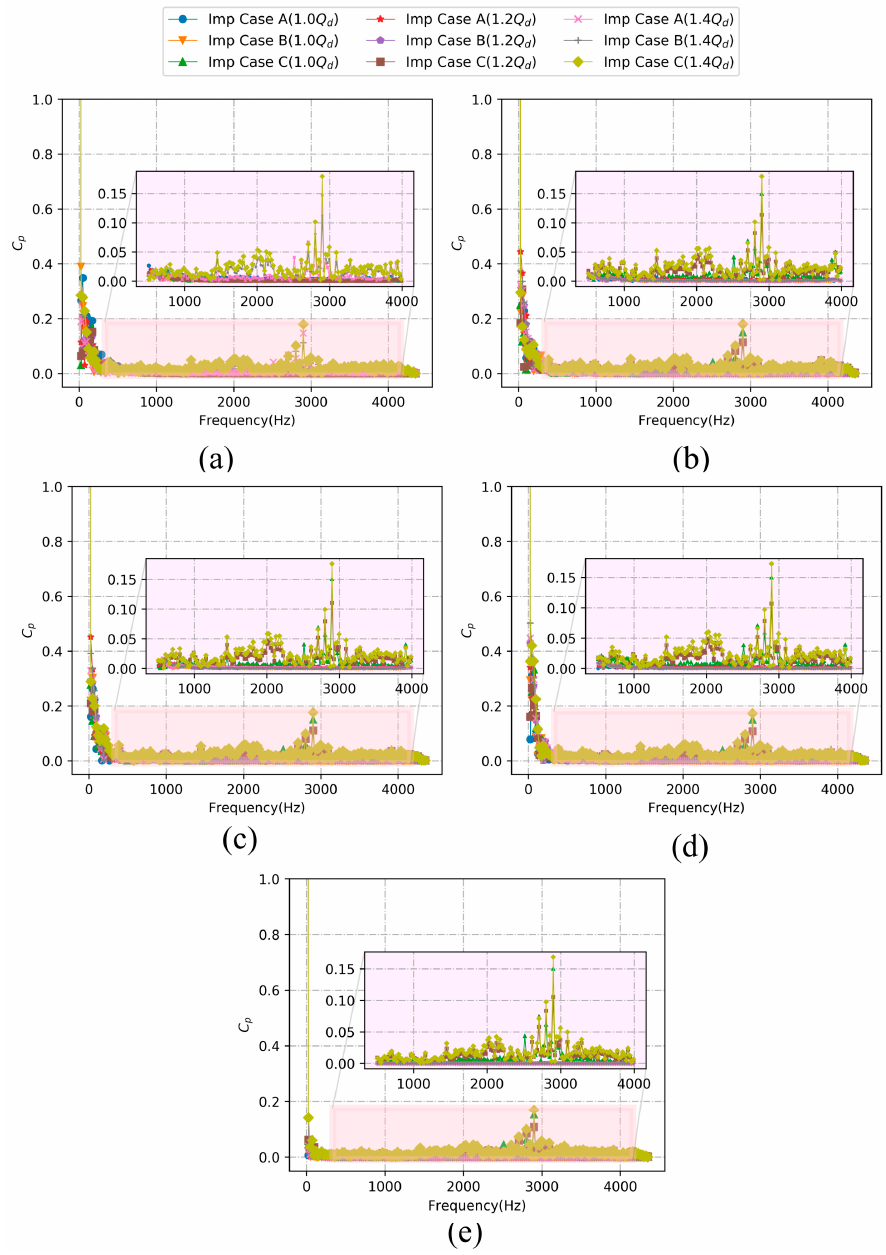
Figure 20. Frequency domain history of pressure fluctuation in impeller flow passage at the locations of: ( a ) Imp1, ( b ) Imp2, ( c ) Imp3, ( d ) Imp4 and ( e ) Imp5.